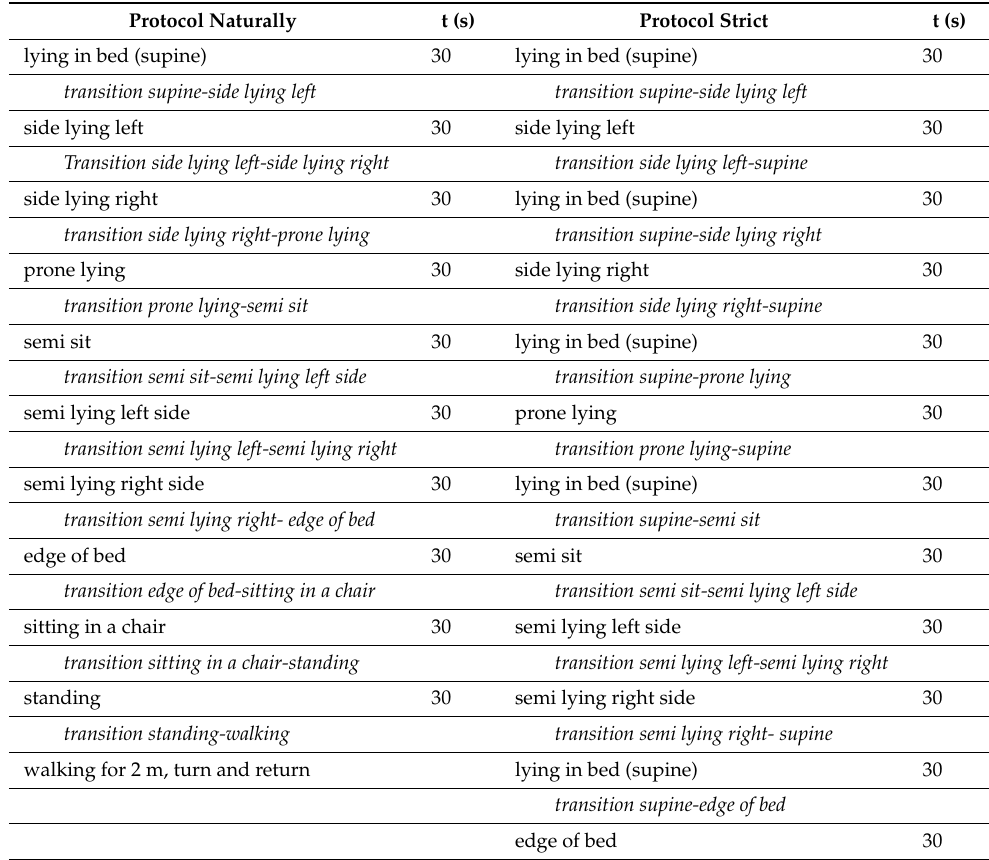
Table A1. Description and Duration of the Different Activities and Transitions for the Four Different